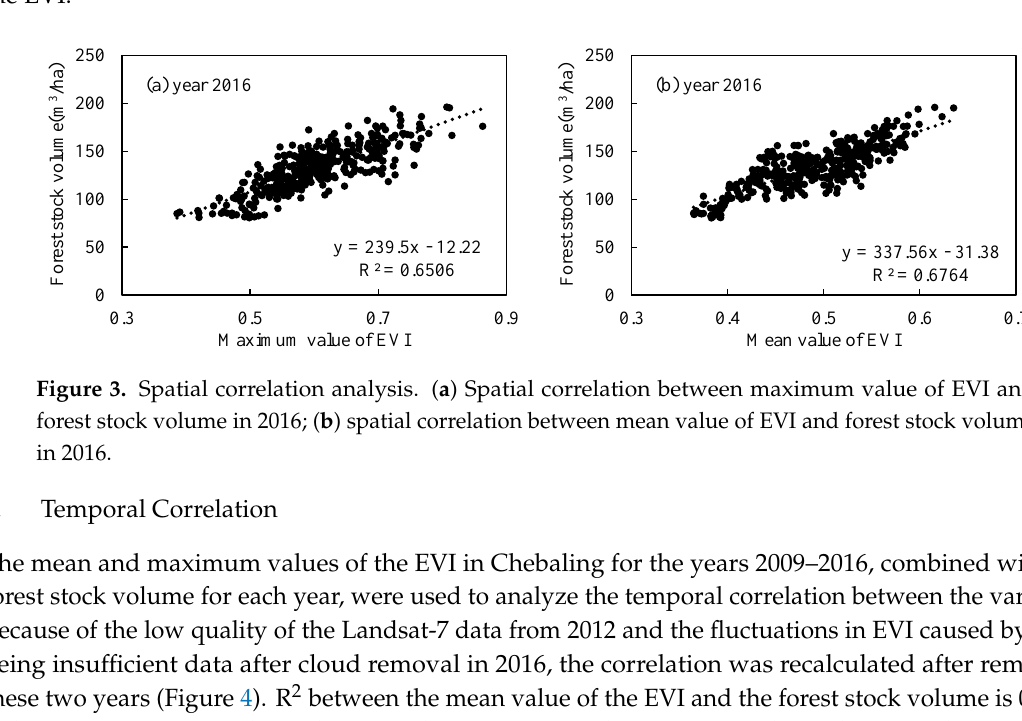
represent the forest stock volume. The mean value of the EVI was thus used for subsequent disaster impact and post-disaster recovery